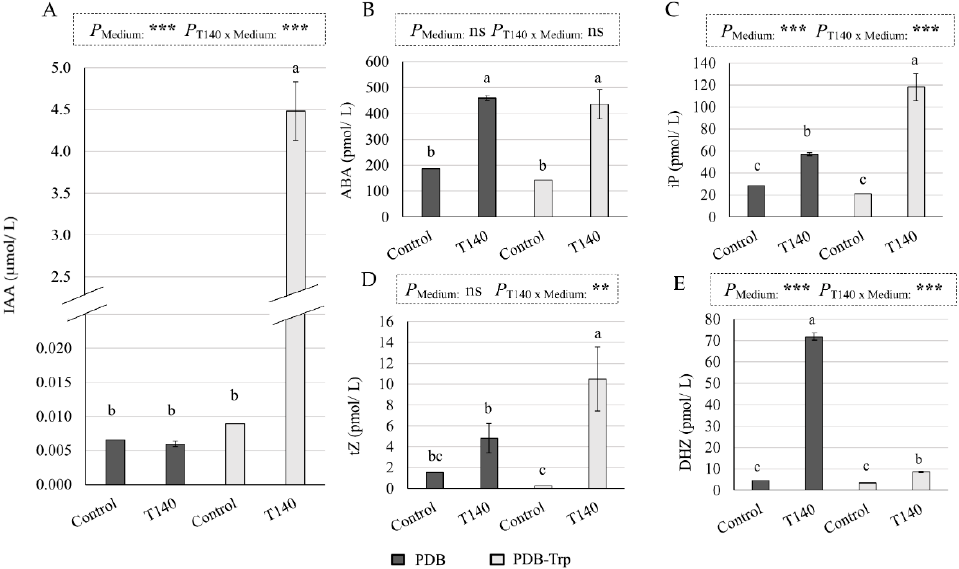
Figure 3. Phytohormone production by strain T140 in 4-day PDB and PDB-tryptophan (Trp) cultures compared to the basal levels of phytohormones detected in PDB and PDB-Trp control media. ( A ) Indole-3-acetic acid (IAA), ( B ) abscisic acid (ABA), ( C ) cytokinin isopentenyladenine (iP), ( D ) cytokinin trans-zeatin (tZ), and ( E ) cytokinin dihydrozeatin (DHZ) are calculated from three replicates per strain and the culture medium ( n = 3). Values correspond to μ mol or pmol per liter of culture supernatant. For each phytohormone and culture medium, different letters above the bars indicate significant differences according to one-way analysis of variance (ANOVA) followed by Tukey’s test ( p < 0.05). For each phytohormone, a significant effect was determined using a two-way ANOVA for “T140 application”, “culture medium”, and their combination (***: p < 0.001; **: p < 0.01; ns: no statistical differences).